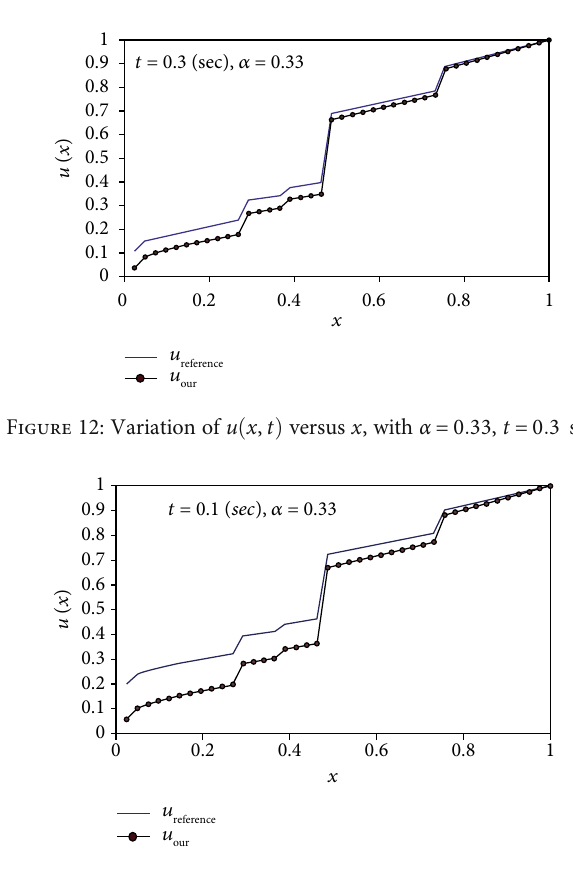
Figure 13: Variation of u ð x , t Þ versus x with α = 0 : 33 , t = 0 : 1 sec